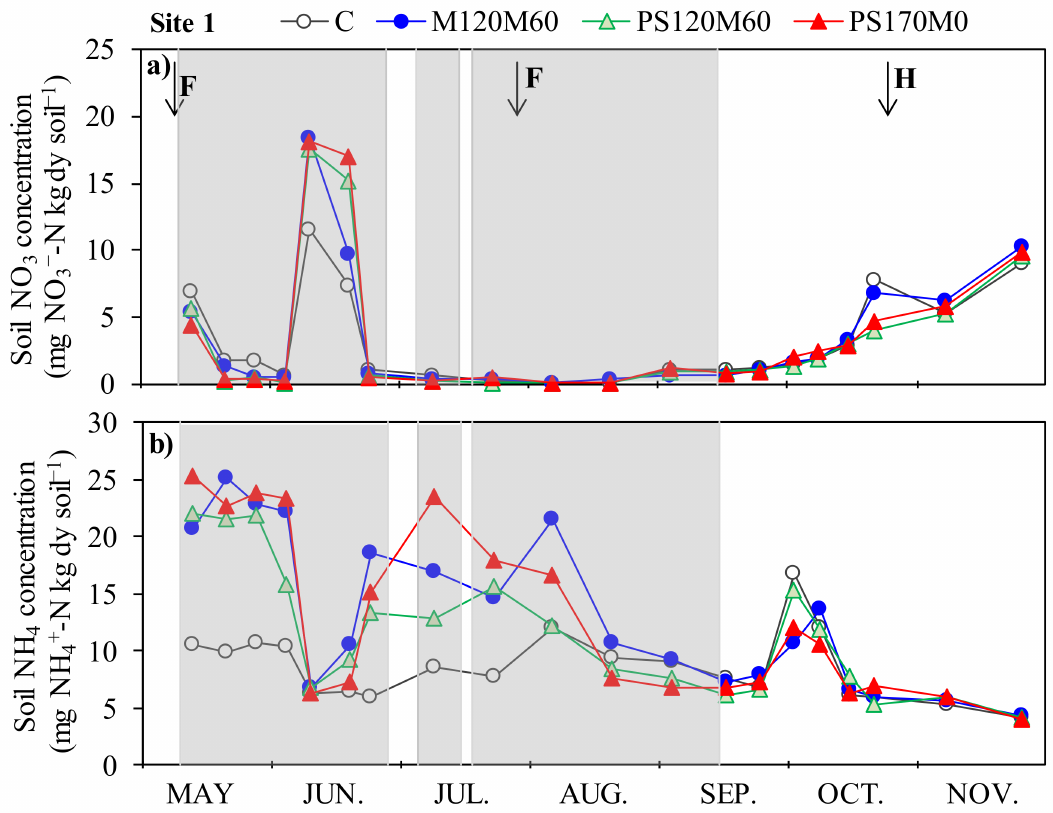
Figure 4. Site 1 (Villanueva de Sigena) year 2013. Soil (0–0.1 m) ( a ) nitrate and ( b ) ammonium concentration during the studied period as a ff ected by the fertilization treatment. Vertical arrows indicate the dates of fertilization applications (F) and harvest (H). The grey shaded areas represent the periods in which the water inflow to the plot was